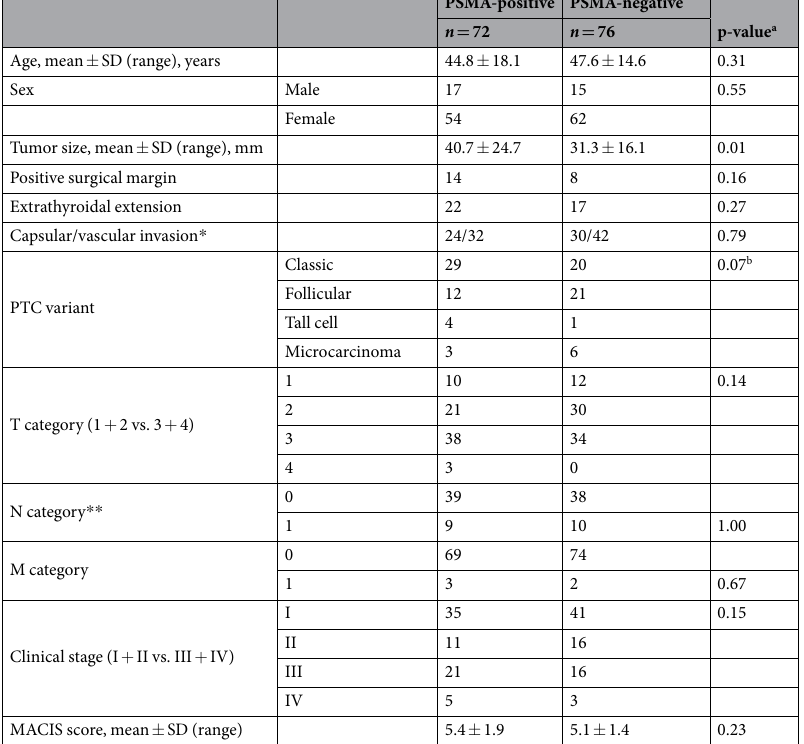
Table 2. Relationship of PSMA expression to clinicopathological parameters in well differentiated (primary papillary and follicular) thyroid carcinomas. a Two-tailed values based on t-test for continuous variables and Fisher’s exact test for categorical variables. b Chi square test. * Only encapsulated tumors. ** Only papillary cancers.